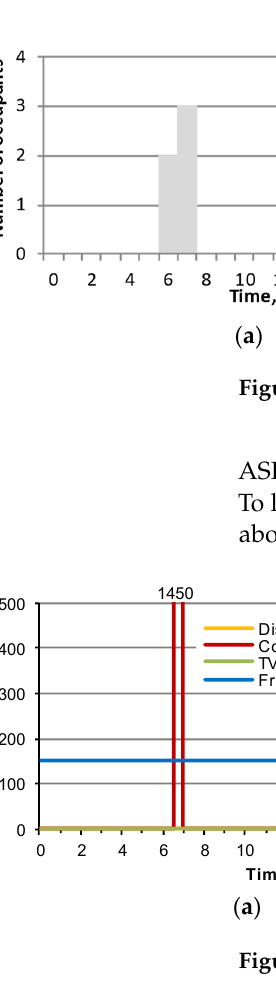
Figure 5. Heat gain from the equipment in the living-room: weekdays ( a ) and weekend ( b ).